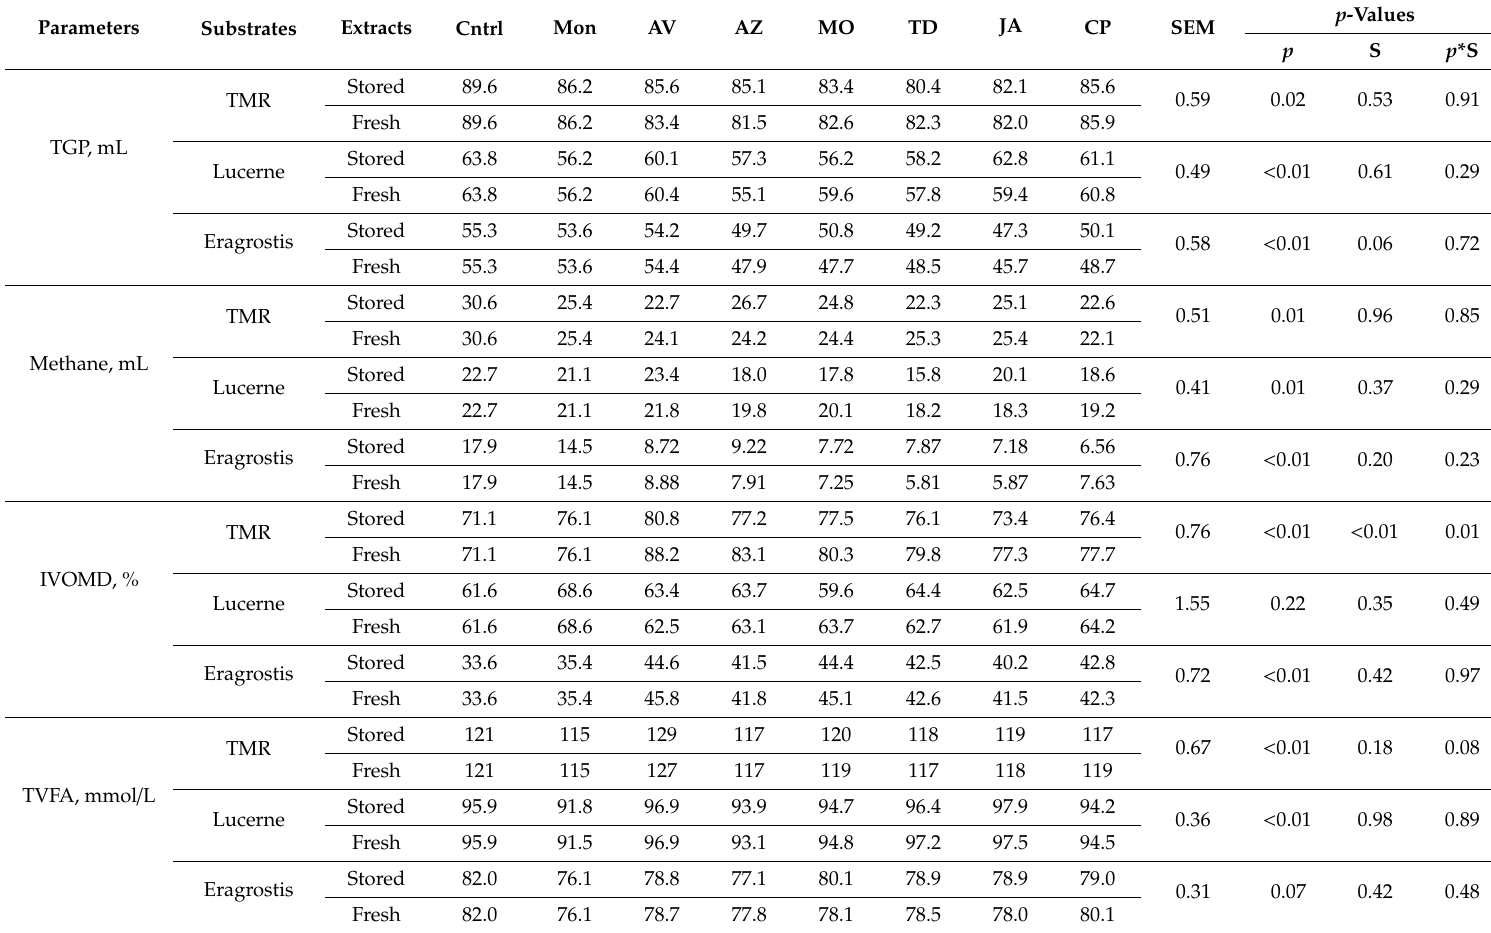
Table 2. Total gas production (TGP), methane, in vitro organic matter digestibility (IVOMD) and total volatile fatty acid (TVFA) from Eragrostis curvula , lucerne and TMR substrates incubated with stored or fresh plant